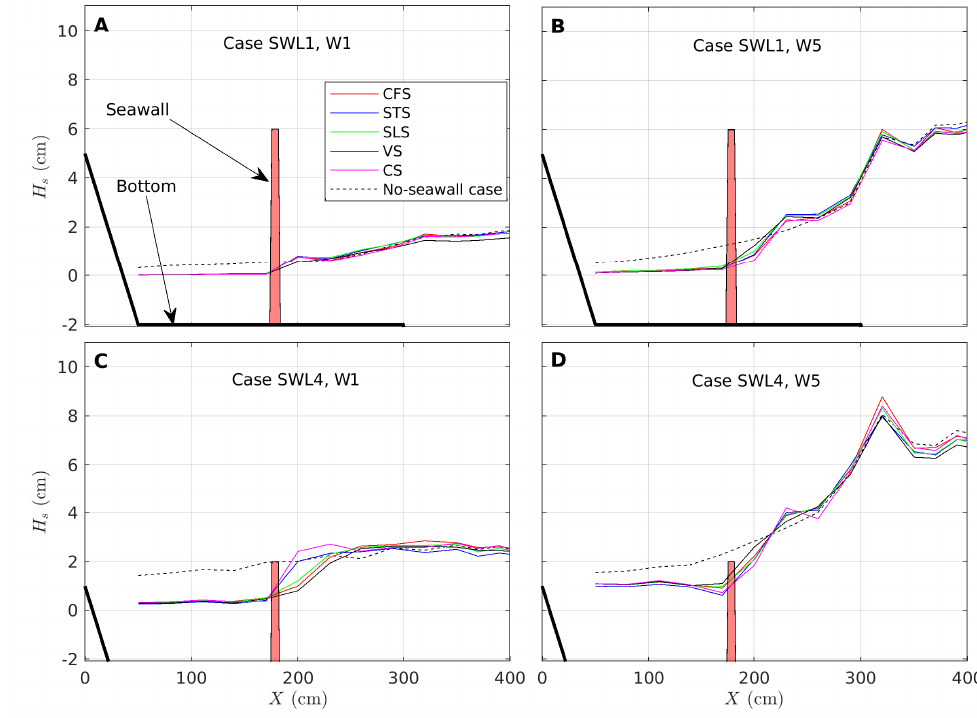
Figure 3. Cross-shore profiles of SW in the no-seawall reference cases (black dashed line) and seawall cases at position ( B ) (colored solid lines). ( A – D ): SWL1/W1, SWL1/W5, SWL4/W1, and SWL4/W5 cases, respectively. The zero for the y-axis corresponds to the still water level for each case. The red dot indicates the seawall position, when present. Note that the breaking point in ( A , B , D ) is located at around X = 320cm, i.e., near the mid forereef slope, which is not represented here, see Figure 2 for complete bottom